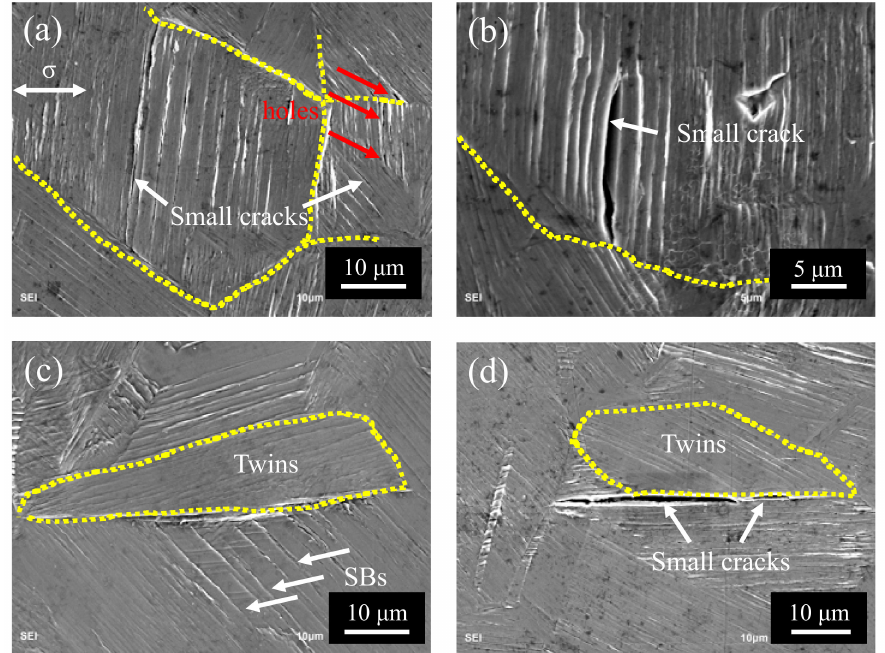
Figure 10. Small cracks in slip bands of the specimen surface at 332 MPa. ( a , b ) Small cracks in grains. ( c , d ) Small cracks in twin